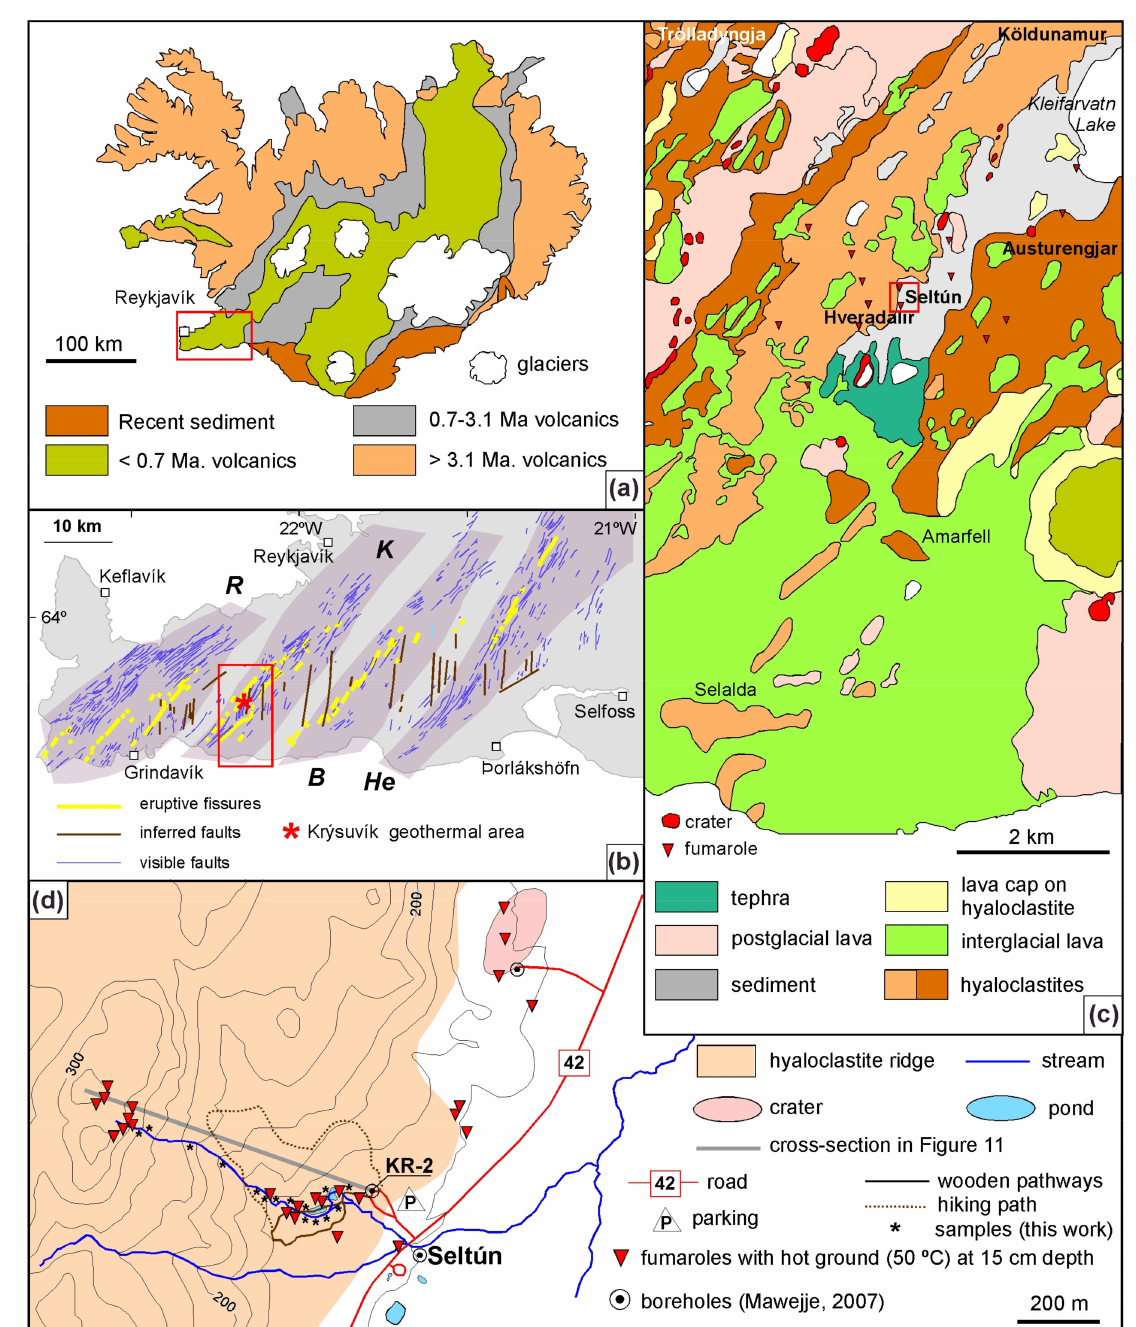
Figure 1. ( a ) Geological sketch of Iceland; based on [43]. ( b ) Setting of eruptive fissures, inferred, and visible faults throughout the Reykjanes peninsula; volcanic zones: R Reykjanes/Svartsengi, K Kr ý suv í k, B Brennisteinsfjöll, He Hengill; modified from [44]. ( c ) Geological map of the Kr ý suv í k geothermal field with location of the Selt ú n area; modified from [27]. ( d ) Sketch of the Selt ú n area showing location of streams, ponds, and sampling combined with a topographic map at scale